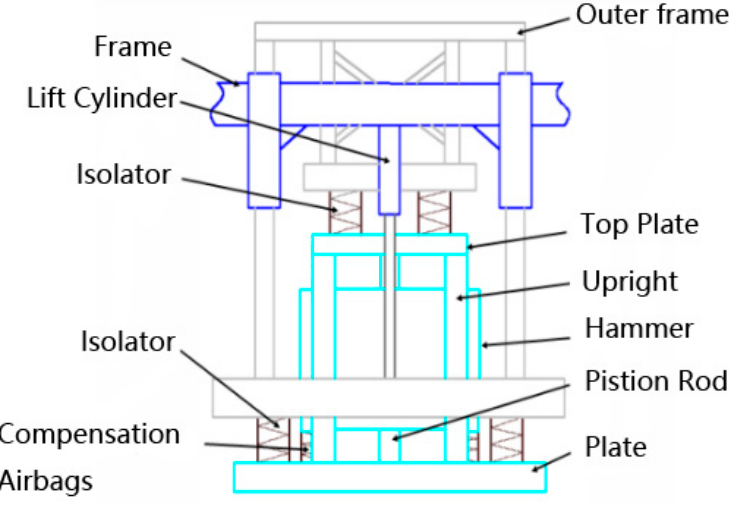
Figure 1. Schematic diagram of vibrator